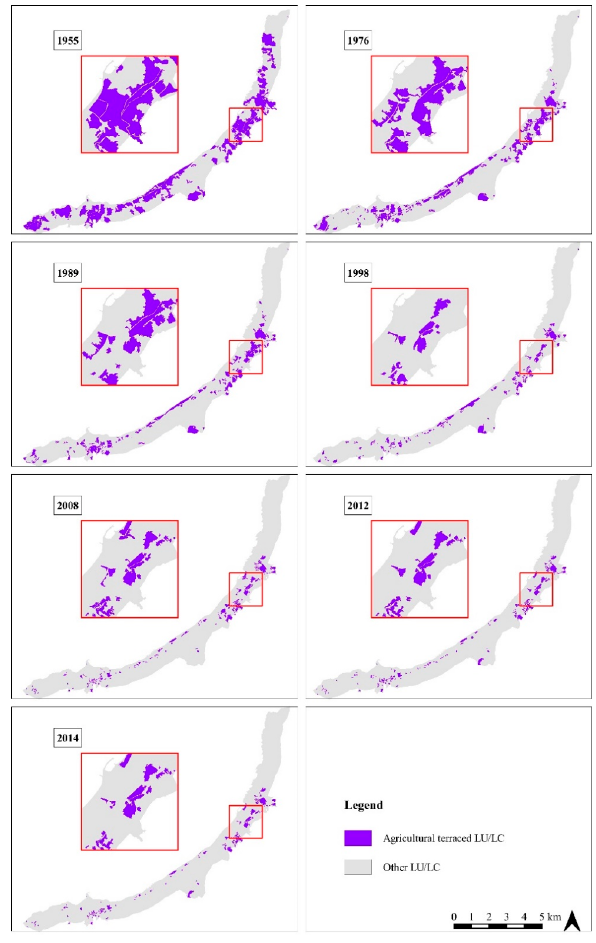
Figure 3. The spatial configuration of agricultural terraced land use/land cover (LU/LC) for each of the years investigated in the time interval 1955–2014.